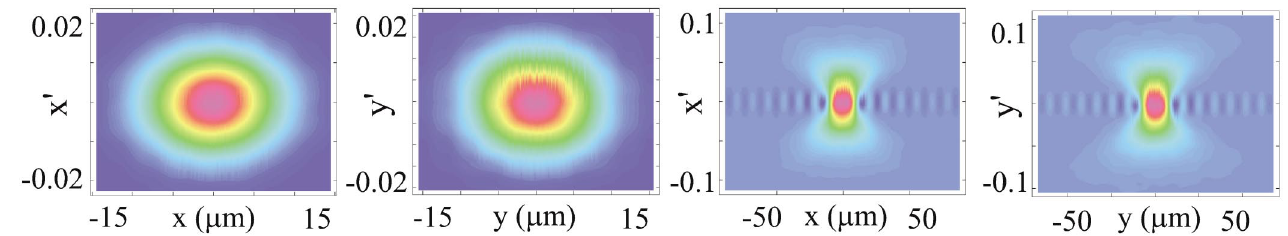
ADJUSTABLE, SHORT FOCAL LENGTH PERMANENT- . .